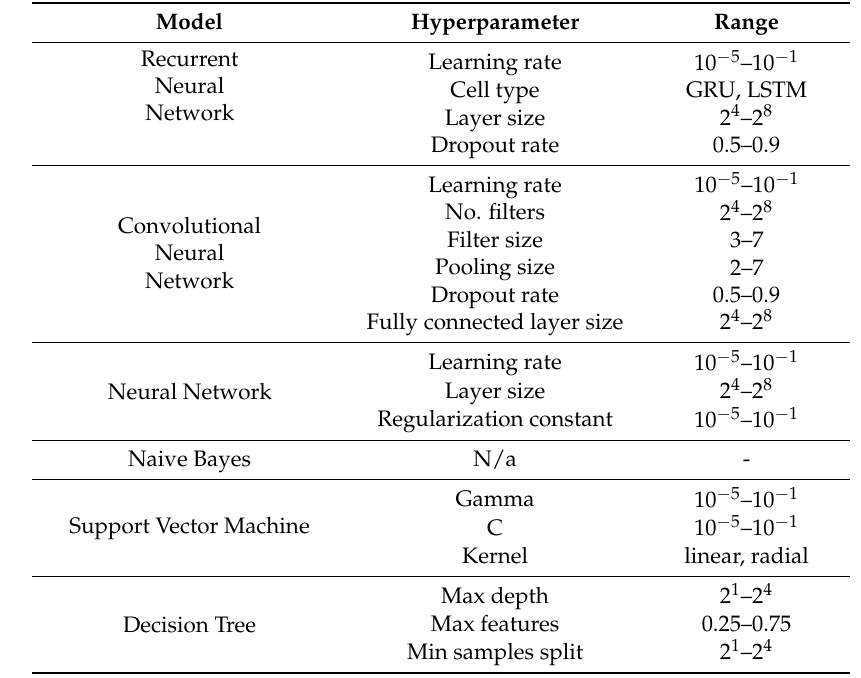
Table 3. An overview of Deep Learning models that take a sequence as input, and classical models that require a single input, along with the relevant hyperparameters that are